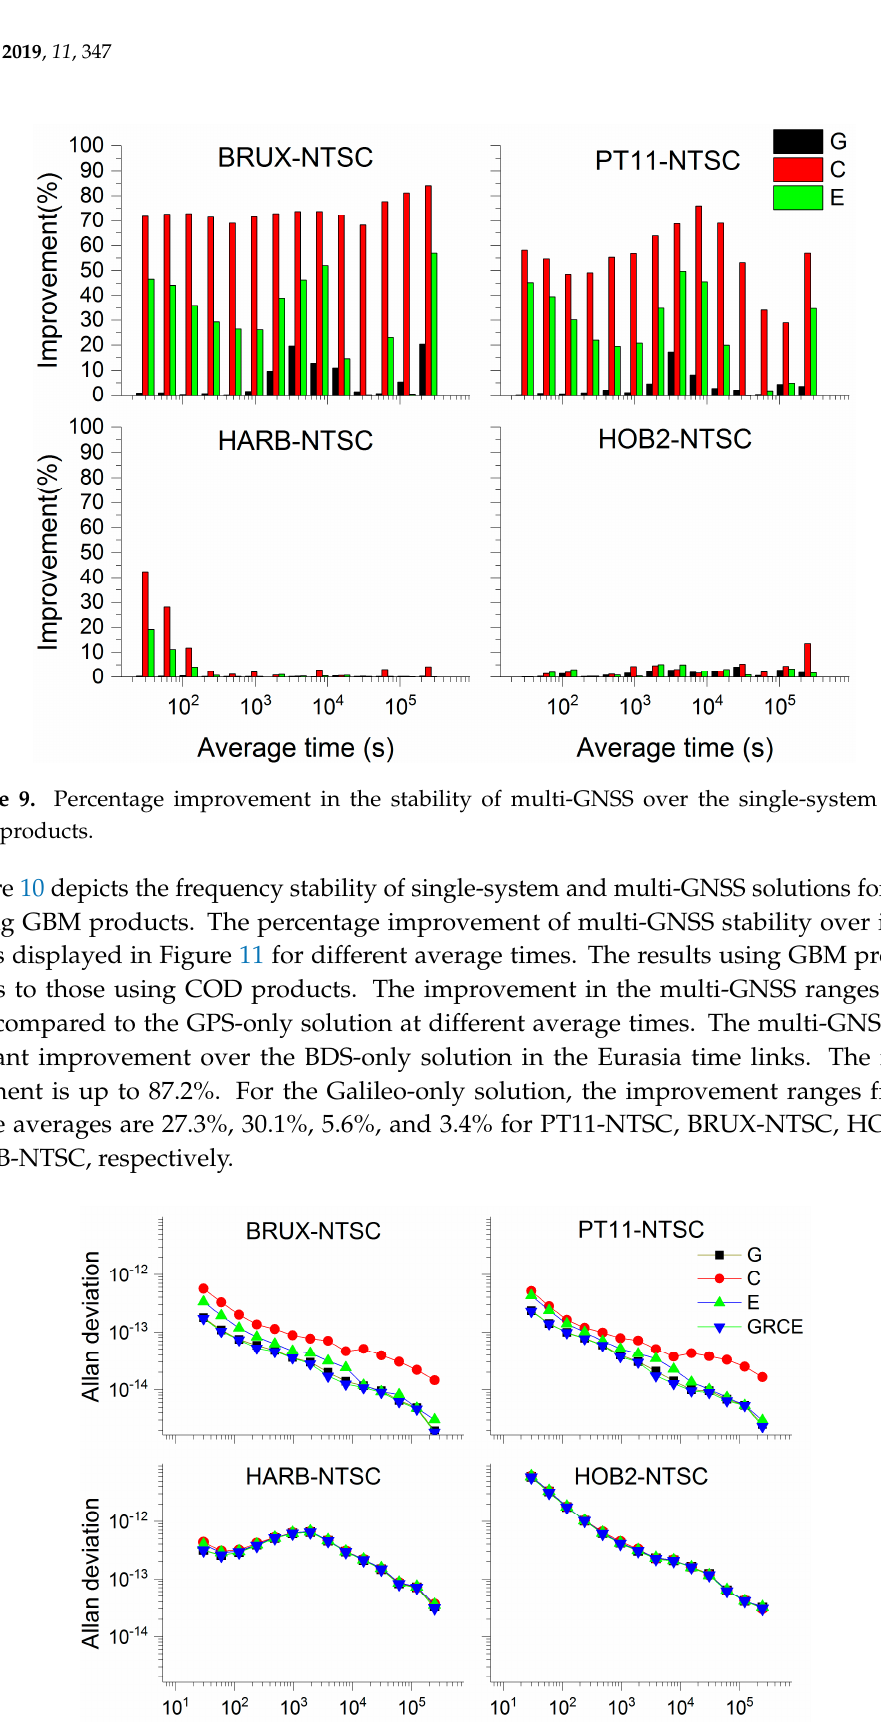
Figure 10. Allan deviation of four time links using GBM products with four models.